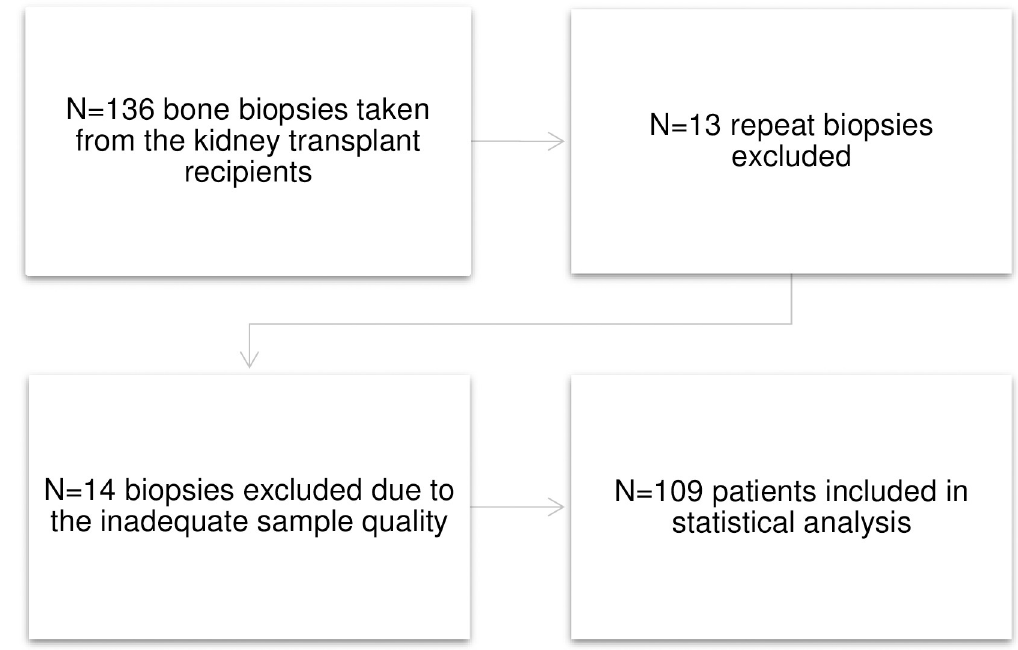
Fig 1. A flow chart of patient